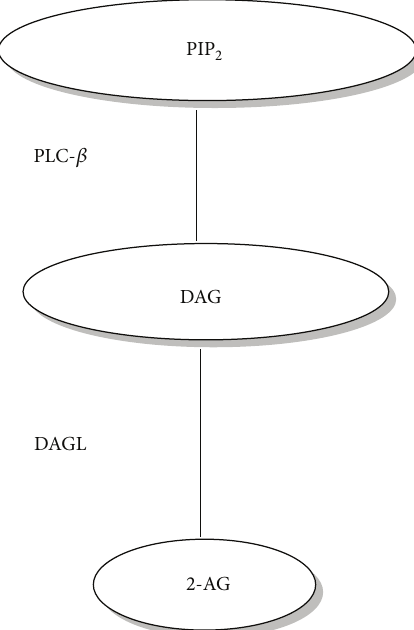
Figure 2: Synthesis of 2-AG. Phosphatidylinositol-4,5-bisphosphate (PIP2) is hydrolysed by phospholipase C- 𝛽 (PLC- 𝛽 ) to form diacylglycerol (DAG). The DAG is then hydrolysed to 2-AG by diacylglycerol lipase (DAGL).